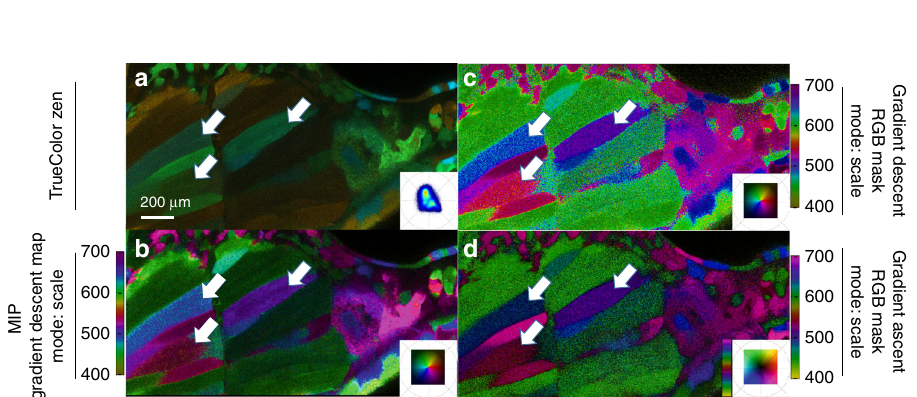
Fig. 7 Visualization of combinatorial expression on Zebrabow samples. Maximum intensity projection renderings of Tg(ubi:Zebrabow) muscle 34 acquired live in multispectral confocal mode with 458 nm excitation. a The elicited signal (e.g., white arrows) is dif fi cult to interpret in the TrueColor Image display (Zen Software, Zeiss, Germany). b Discerning spectral differences is increasingly simpler with gradient descent map scaled to intensities, while compromising on the brightness of the image. c Gradient descent and d gradient ascent RGB masks in scale mode show the color values assigned to each pixel and greatly improve the visual separation of recombined CFP, YFP, and RFP labels. Colorbars represent the main wavelength associated to one color in